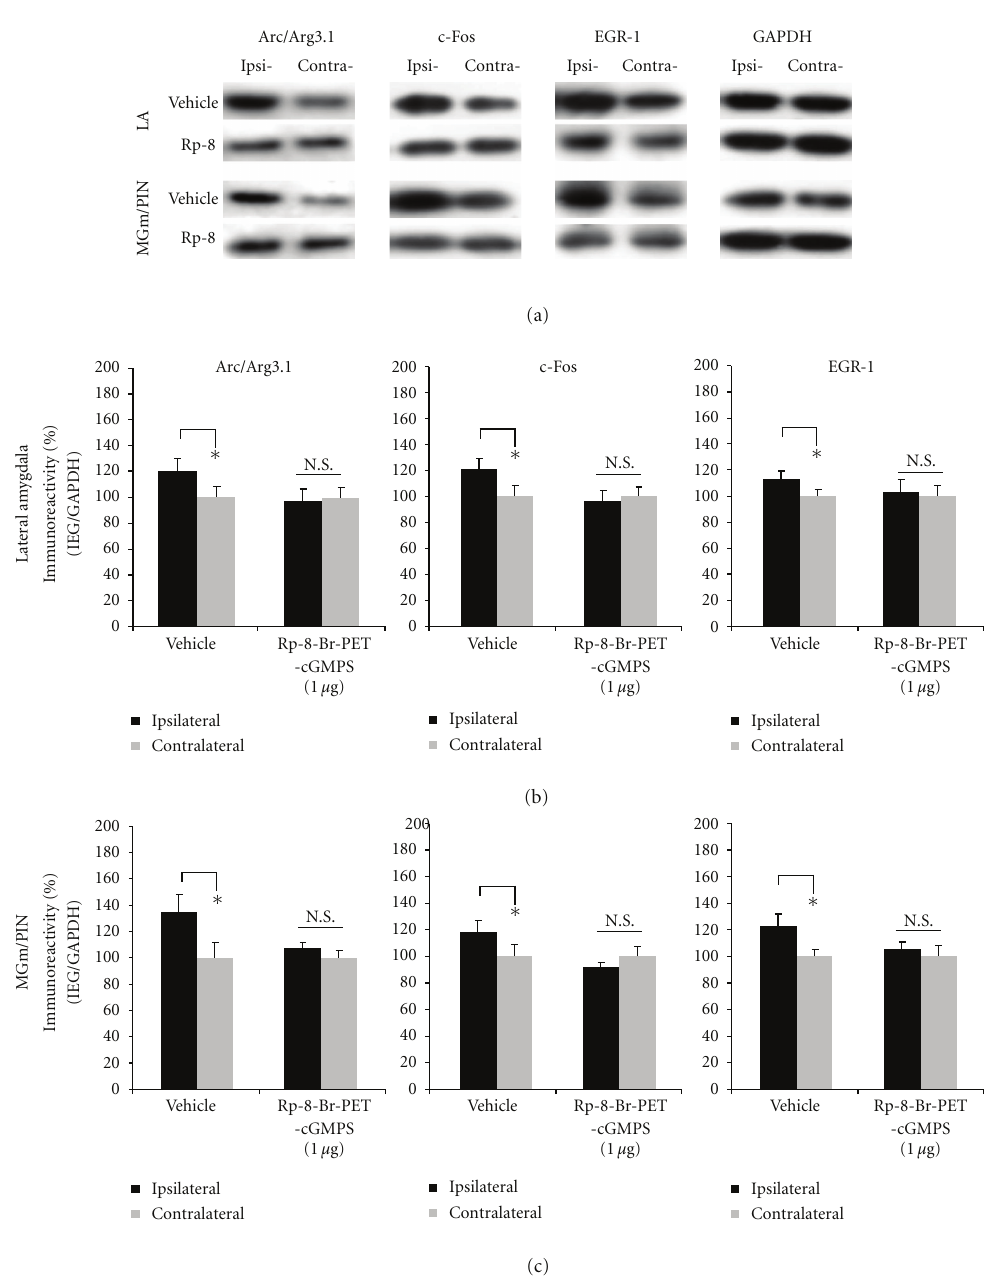
Figure 9: Pharmacological blockade of PKG in the LA impairs ERK-driven IEG expression in both LA and MGm/PIN following HFS. (a) Images of Western blots for Arc/Arg3.1, c-Fos, EGR-1, and GAPDH from both LA (top) and MGm/PIN (bottom) samples. (b) Mean ( ± SEM) percent Arc/Arg3.1, c-Fos, and EGR-1 immunoreactivity from LA punches taken from rats given intra-LA infusion of ACSF (vehicle; n = 8) or 1 μ g/side Rp-8-Br-PET-cGMPS ( n = 8). (c) Mean ( ± SEM) percent Arc/Arg3.1, c-Fos and EGR-1 immunoreactivity from MGm/PIN punches taken from rats given intra-LA infusion of ACSF (vehicle; n = 8) or 1 μ g/side Rp-8-Br-PET-cGMPS ( n = 8). In each figure, IEG levels have been normalized to GAPDH for each sample, and IEG expression on the ipsilateral side has been expressed as a percentage of that on the contralateral side for each rat. ∗ P < . 05 relative to the ipsilateral side N.S. = not significant.